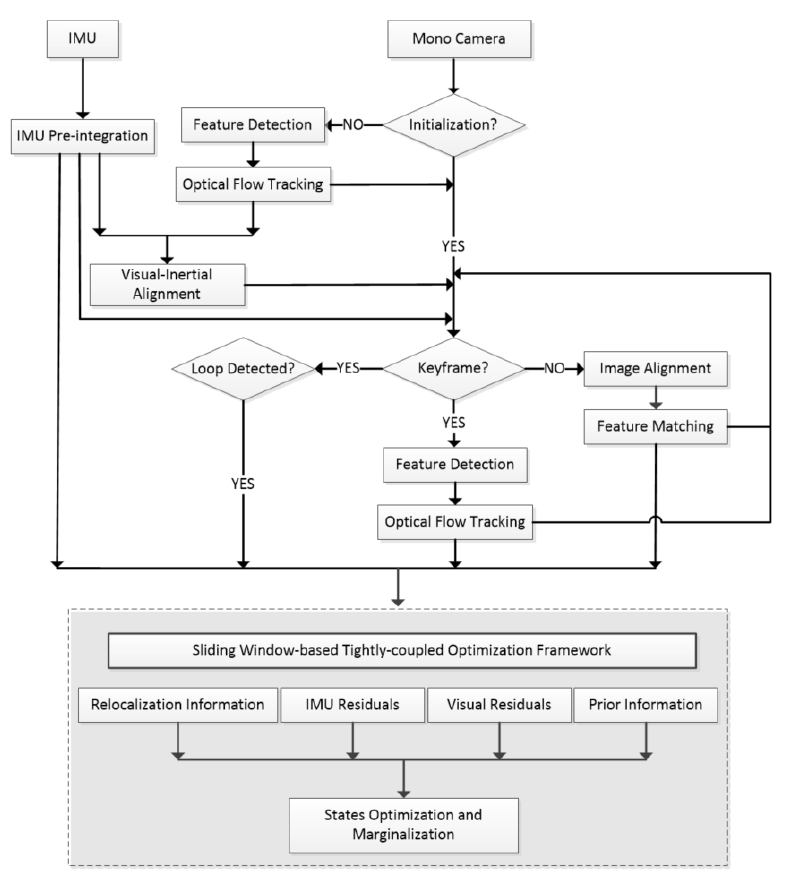
Figure 1. The semi-direct visual-inertial SLAM system framework